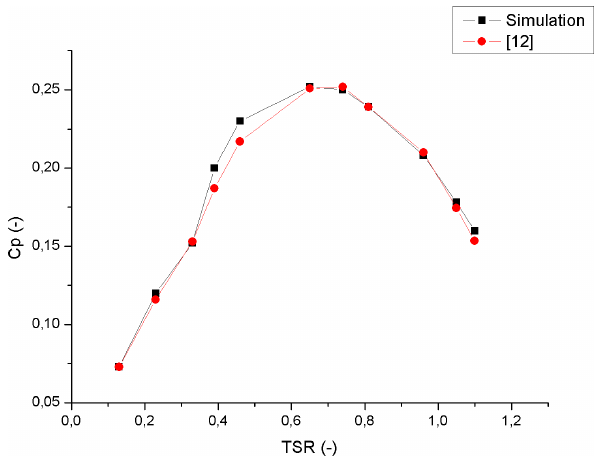
Figure 3: Graph of benchmarking simulation with Roy’s experiment [23].